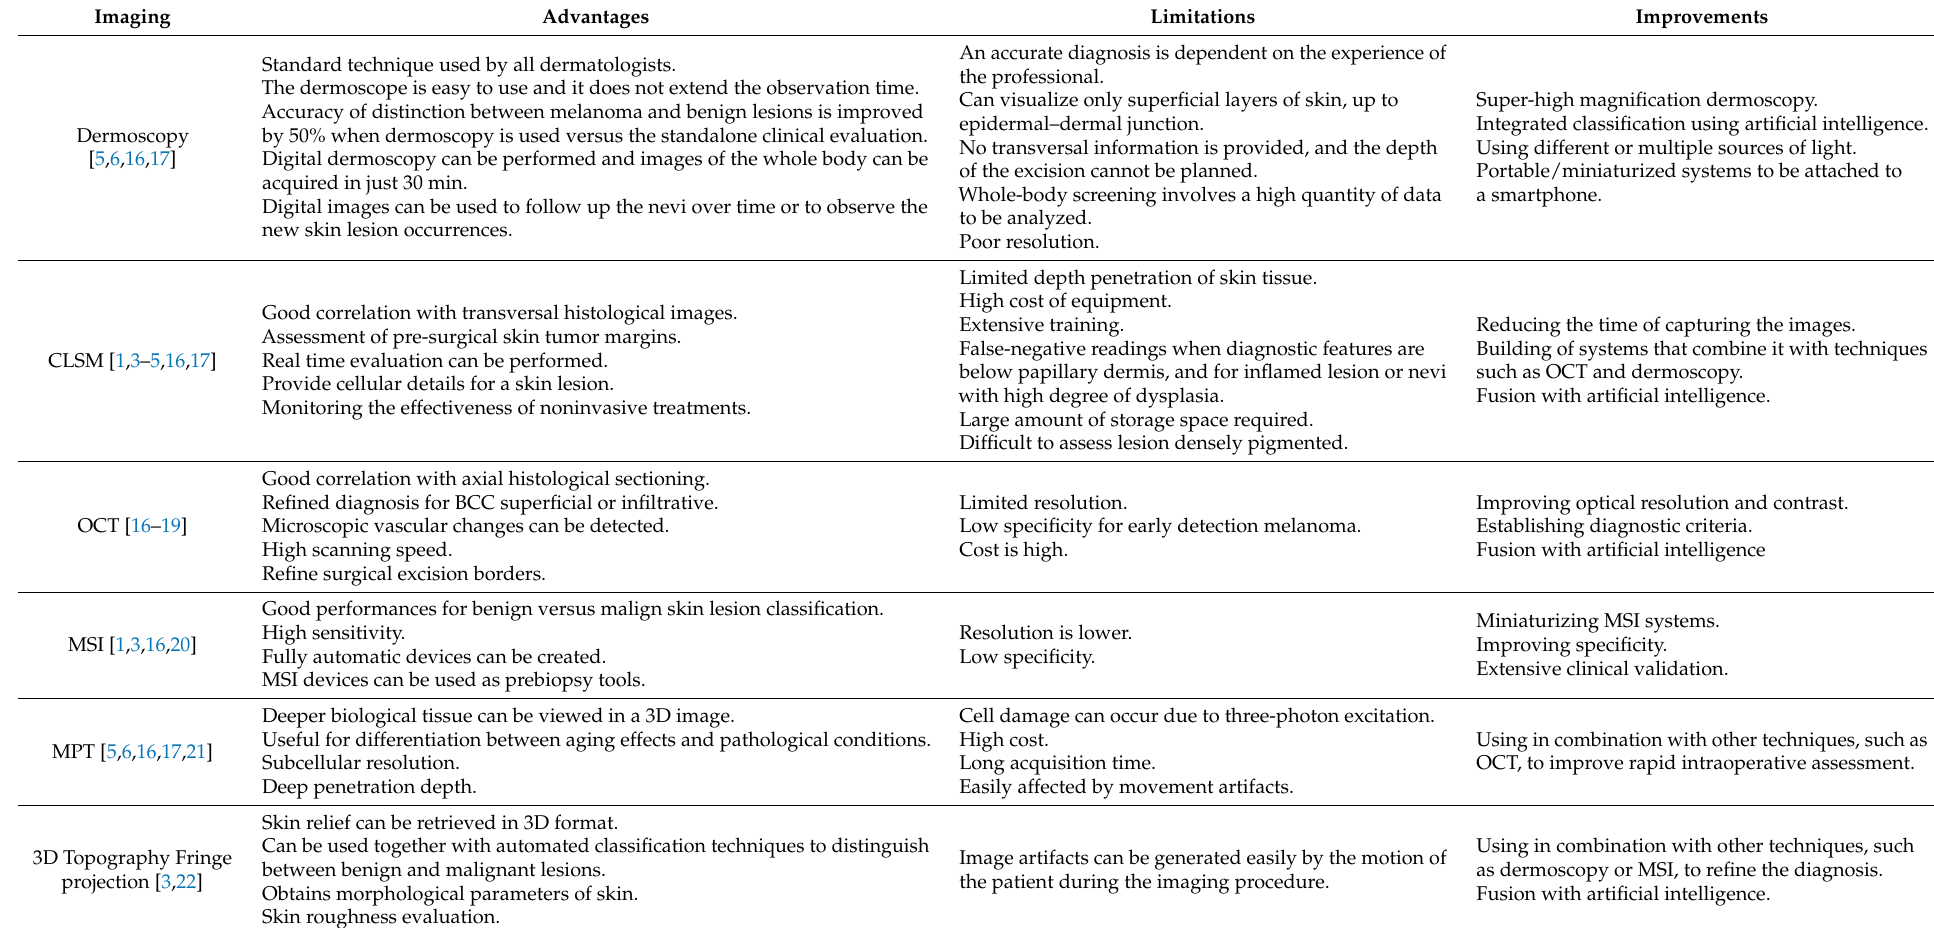
Table 2. Advantages, limitations and possible future improvements of the imaging techniques used for skin